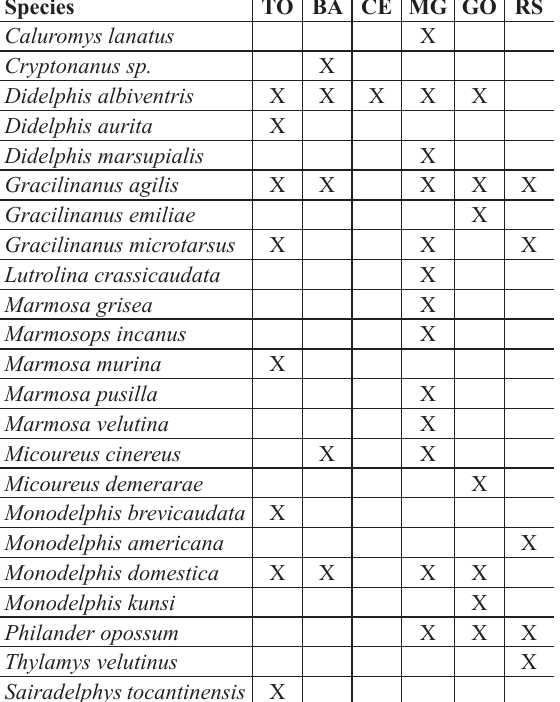
List of didelphidae species from the Pleistocene- Holocene of Brazil taken from Cartelle (1999), Salles et al. (1999) and Hadler et al.